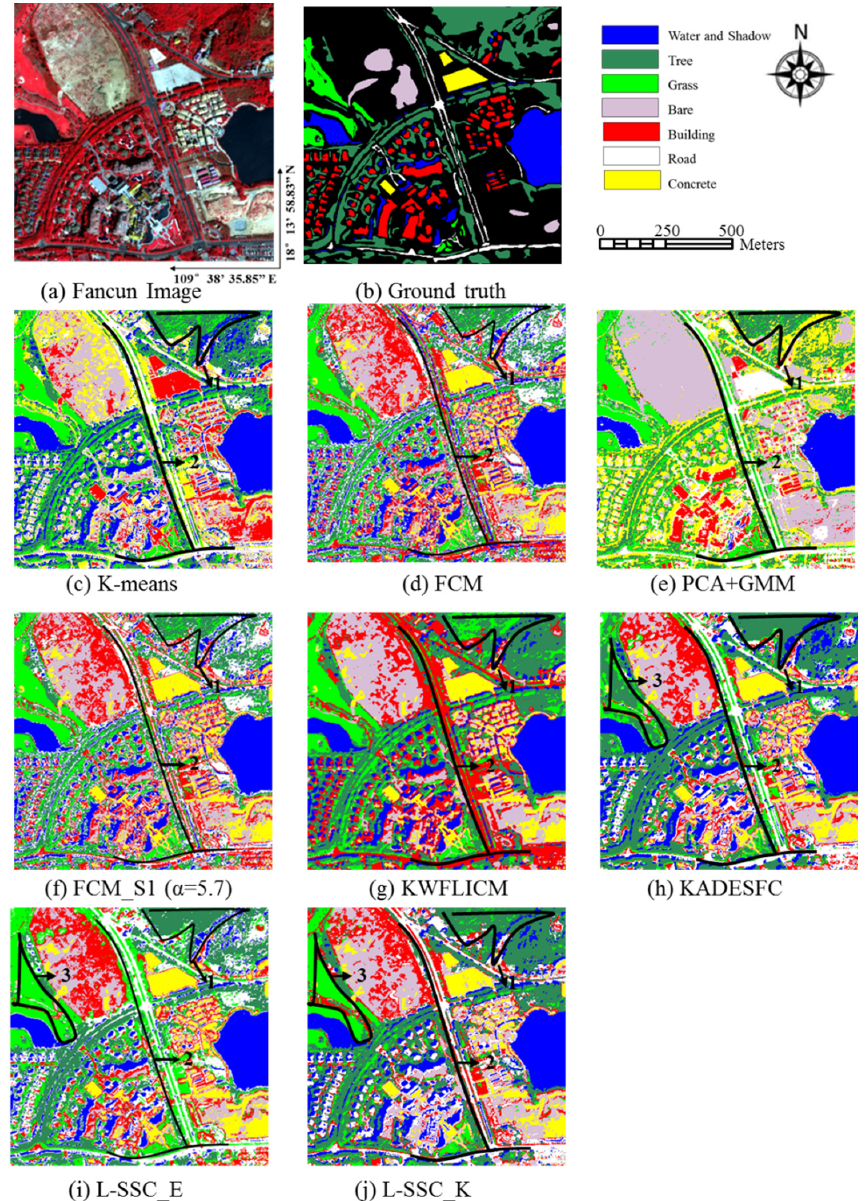
Figure 9. Fancun image and its clustering results. ( a ) WuhanTM image; ( b ) Groundtruth; ( c ) K-means;